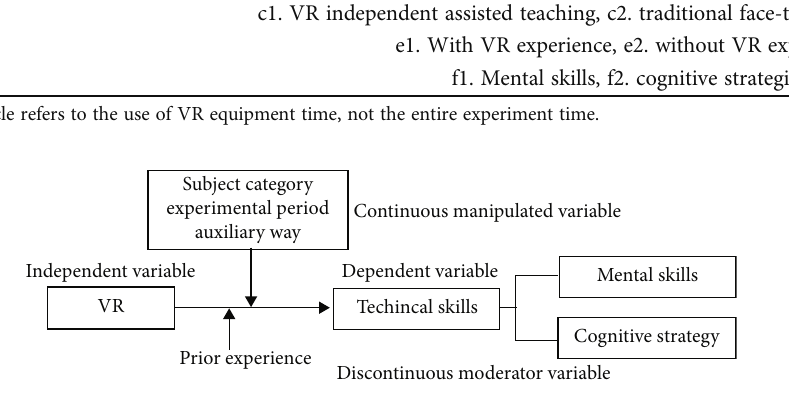
Figure 2: Meta-analysis